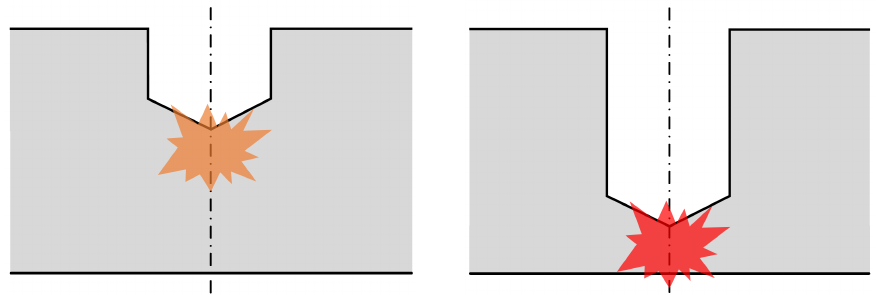
Figure 11. Overheating of the cutting zone just before the end of the drilling